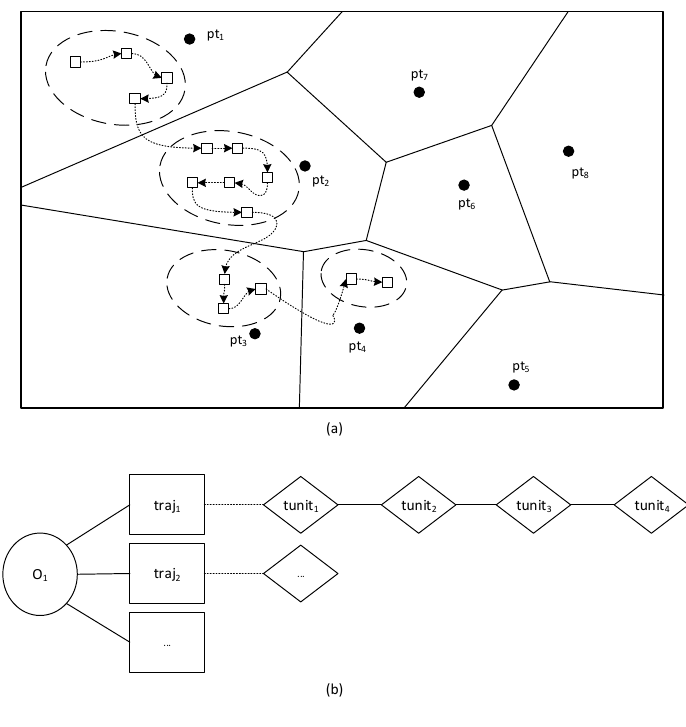
Figure 3. Movement